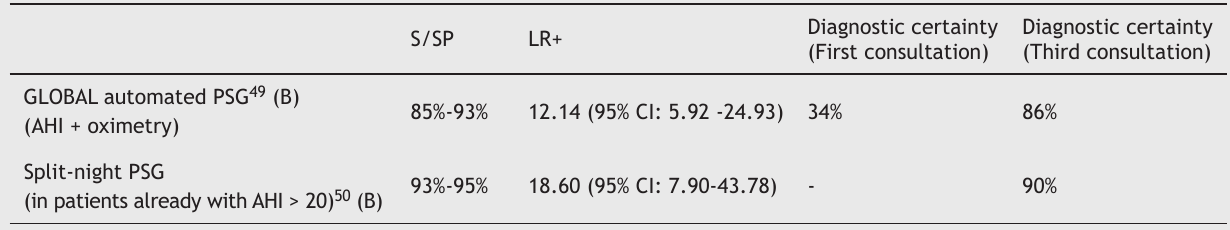
Table 3 Diagnostic probability by polysomnography (PSG).